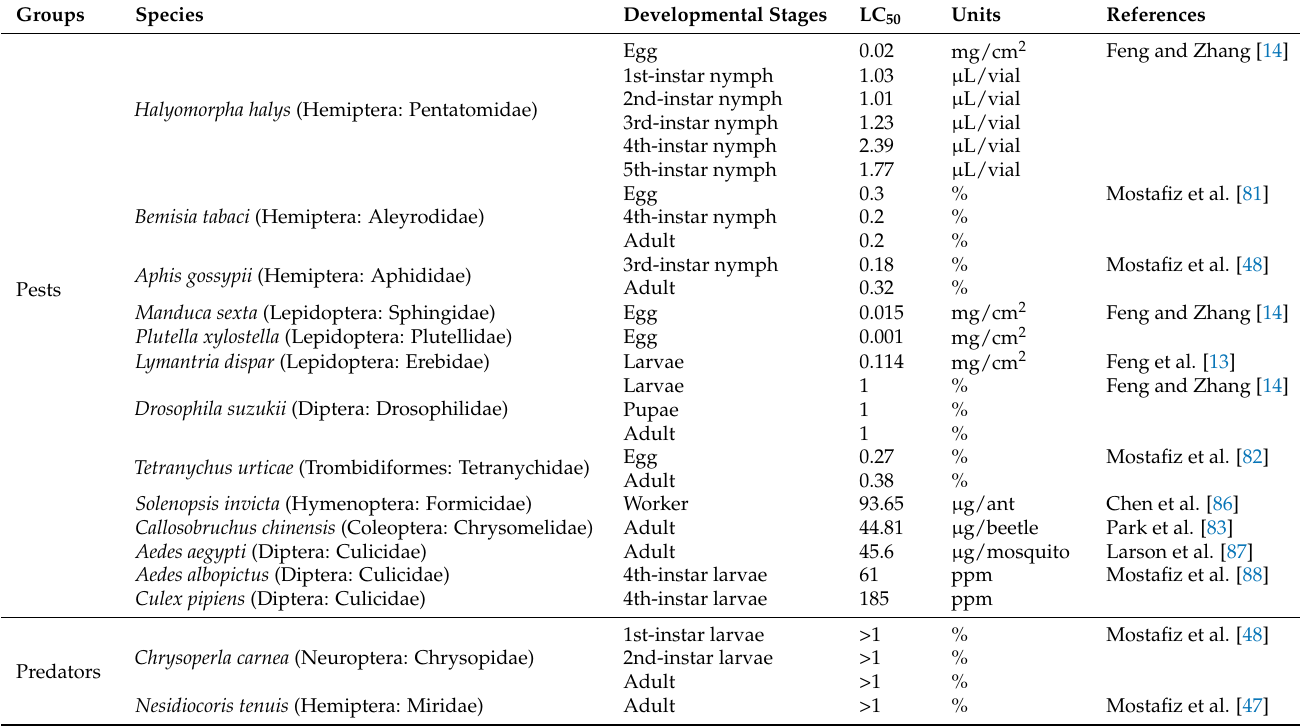
Table 1. Contact toxicity of methyl benzoate for major pests and predators with LC 50